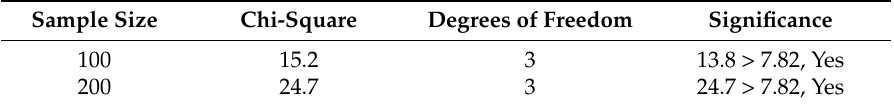
Table 4. Chi-square test results.